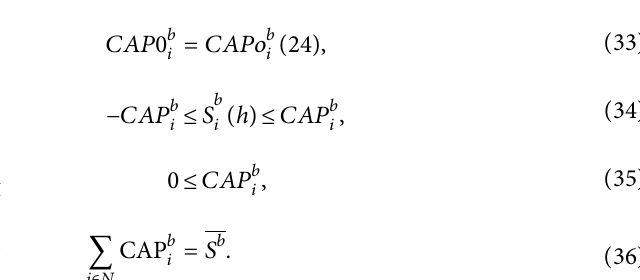
Figure 1: Irradiance and demand profles implemented in multiperiod